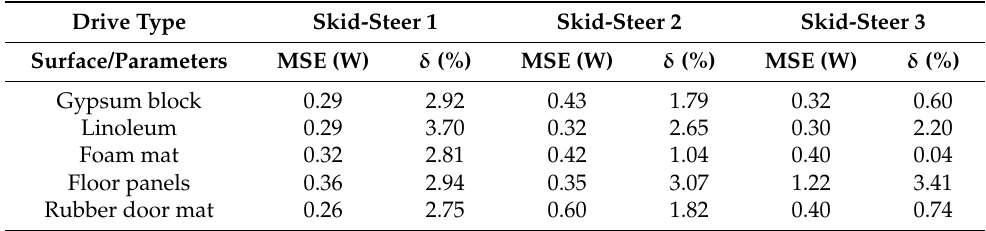
Table 9. The calculated values of quality factors for the mathematical model of skid-steer drive robots. Drive Type